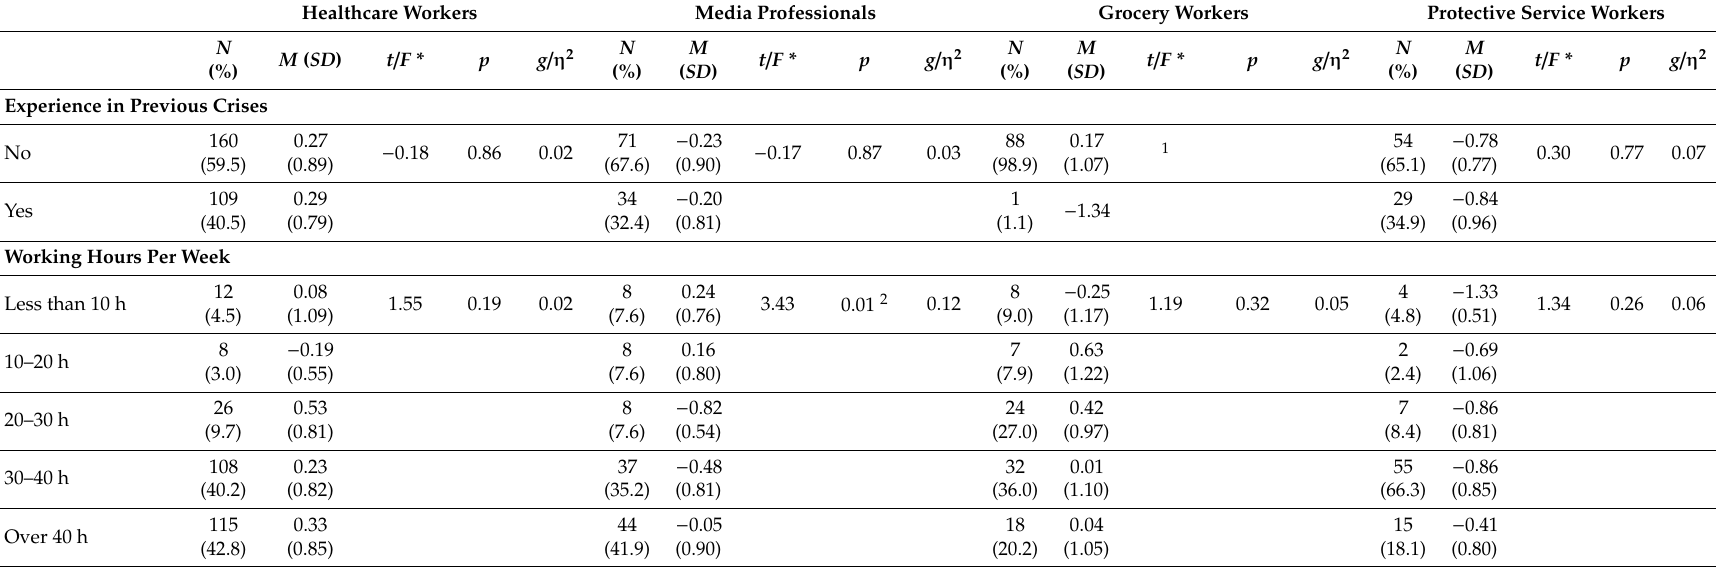
Table 4. Descriptive data of common work-related variables and association with IES-R standardized factorial